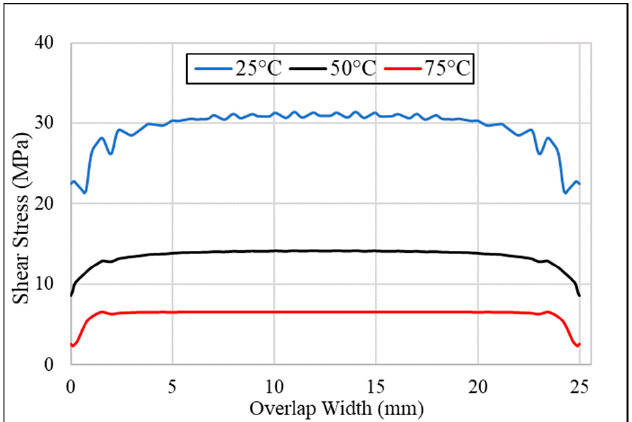
Figure 12. Shear stress distribution at location C of SLJ with neat adhesive at different temperatures.